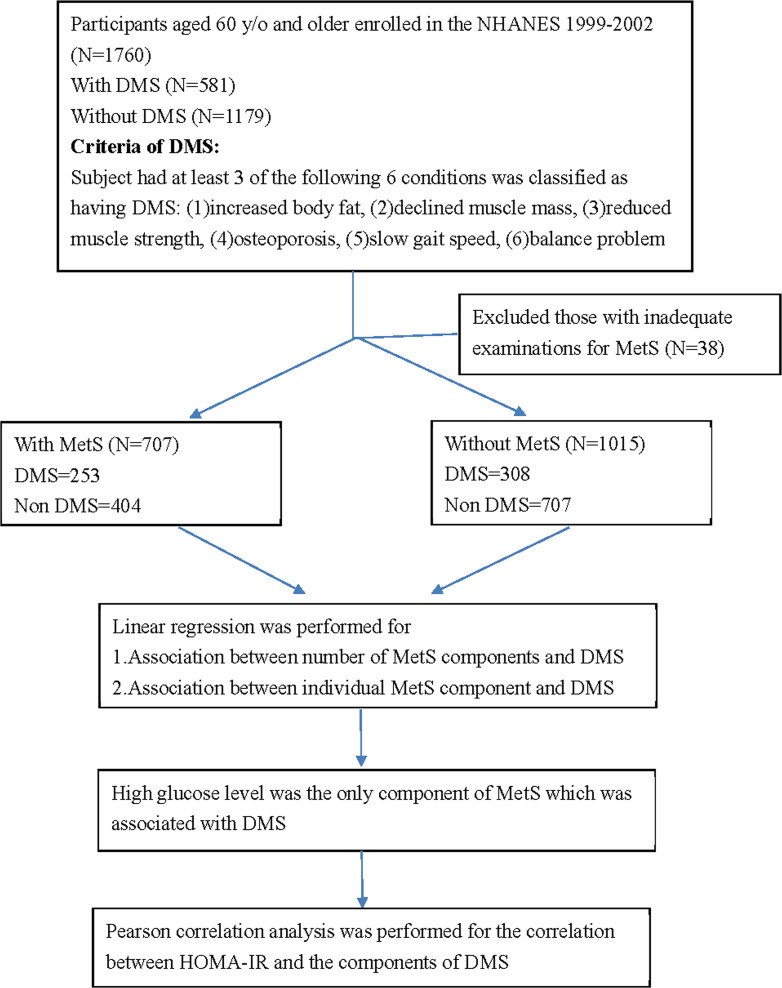
Flow chart of our study.